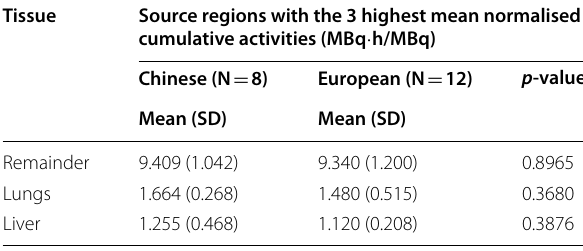
Table 3 Biodistribution in Chinese HVs versus HVs in a European